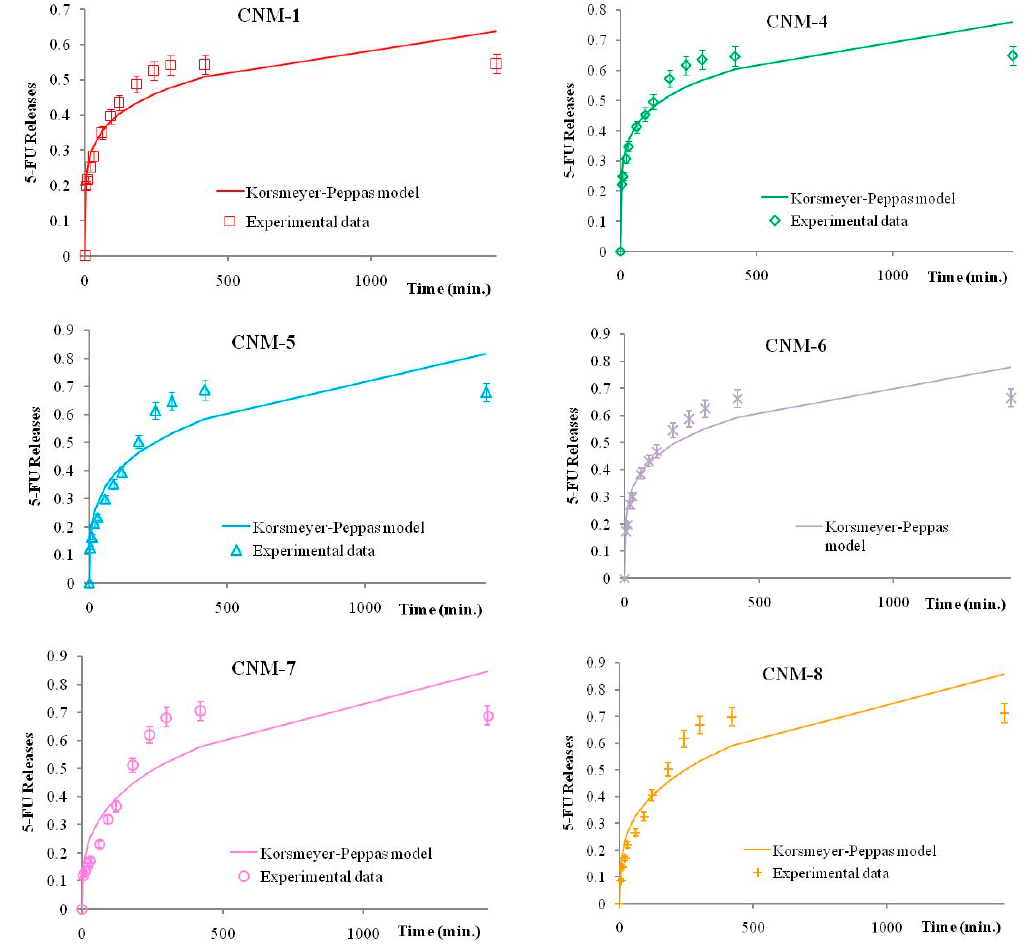
Figure 10. Experimental release kinetics and theoretical Korsmeyer–Peppas curves for magnetic